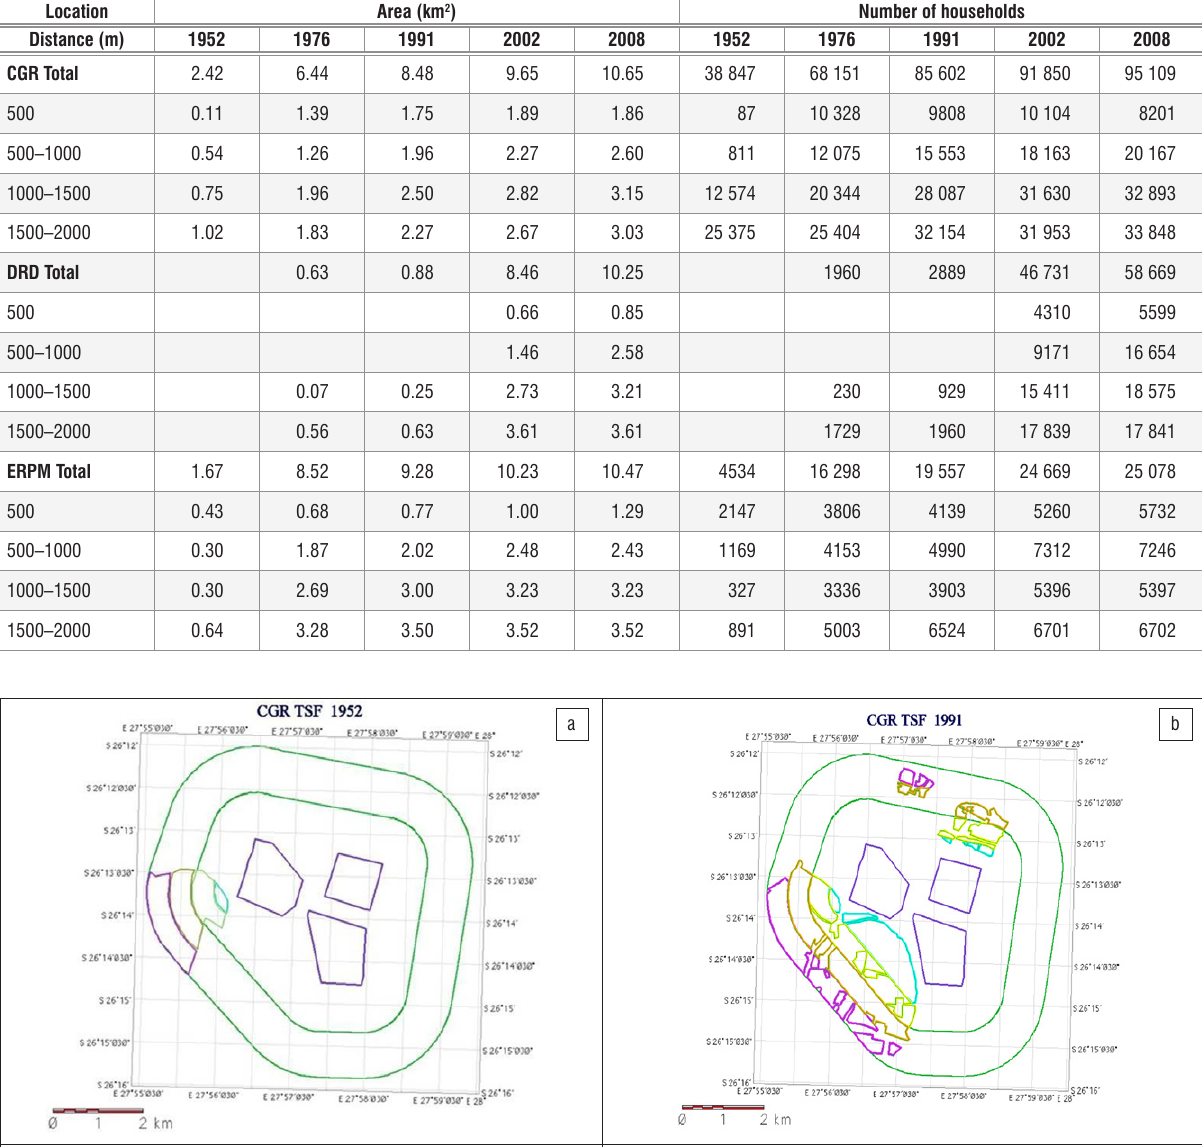
Summary of residential development around Crown Gold Recoveries (CGR), Durban Roodepoort Deep (DRD) and East Rand Proprietary Mine (ERPM) tailings storage facilities, showing changes in the area and number of households or dwellings between 1952 and 2008 Location Area (km 2 ) Number of households Distance